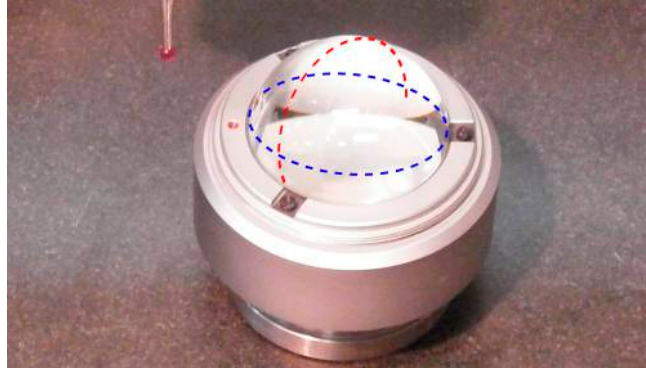
Figure 8. Measuring a glass hemisphere in two planes.